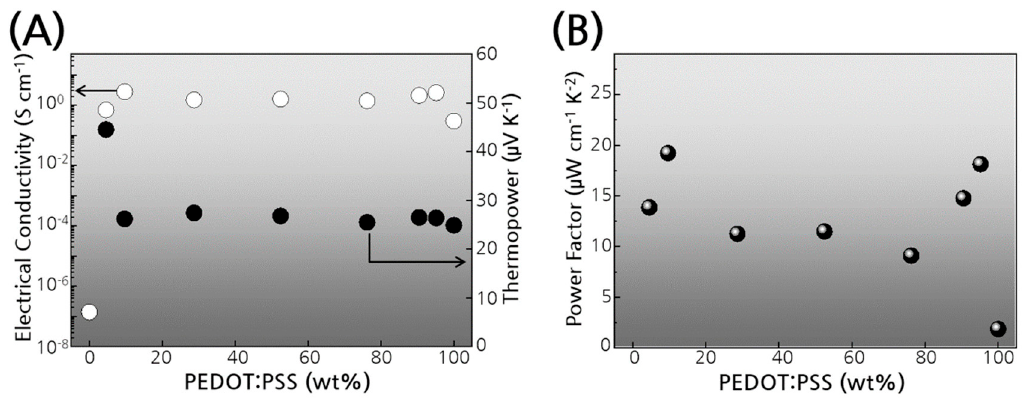
Figure 4. Thermoelectric properties of PEDOT:PSS/Se composite films by varying the composition between PEDOT:PSS and Se. ( A ) Electrical conductivity and Seebeck coefficient. ( B ) Power factor.